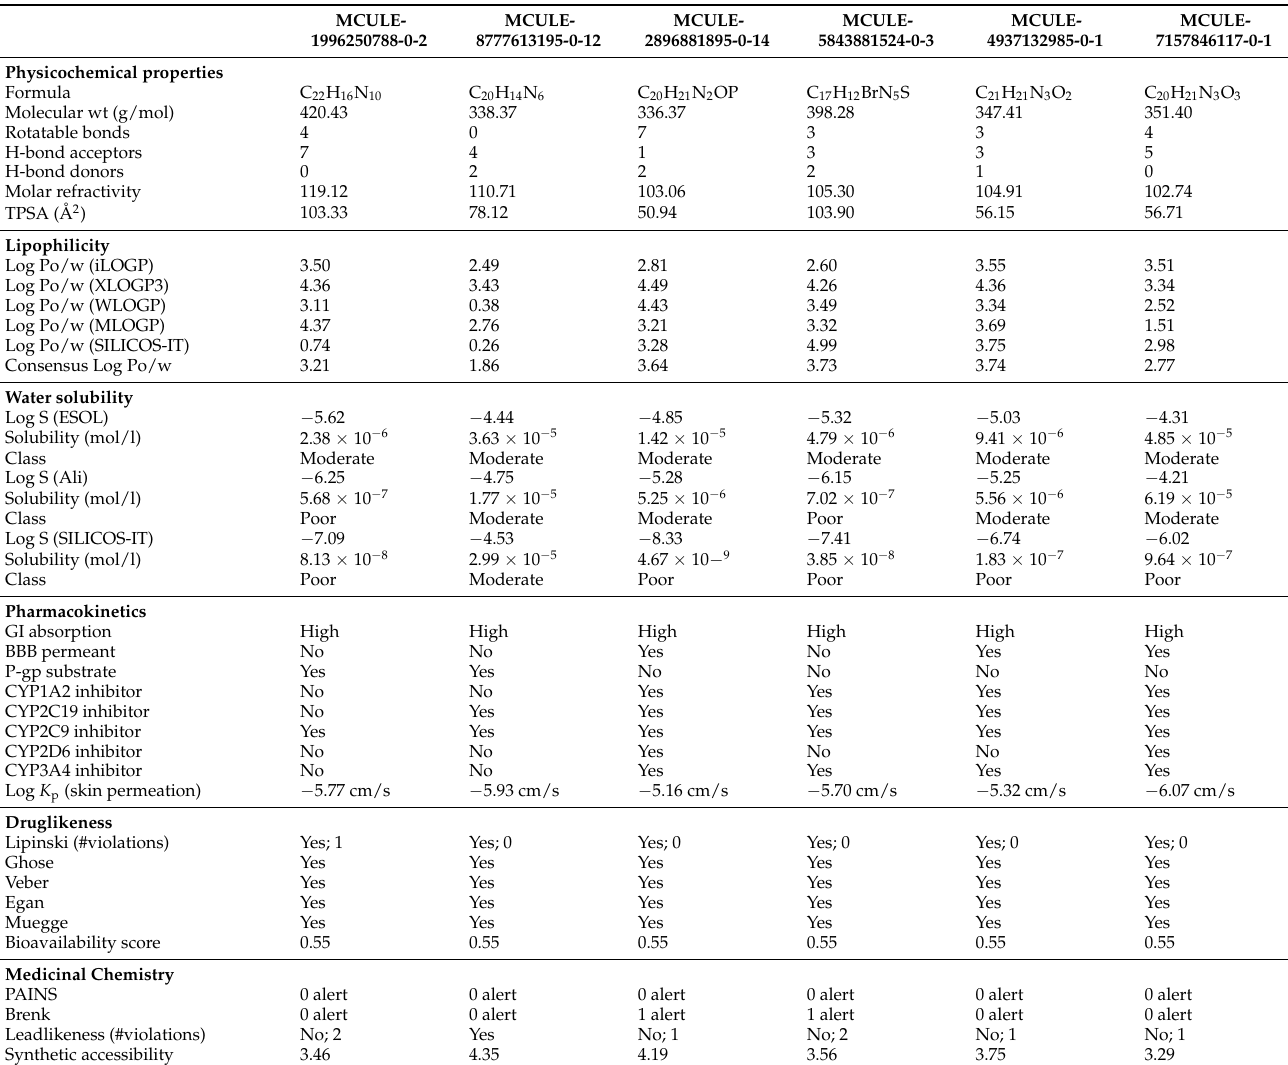
Table 3. ADMET properties of the selected molecules deduced by